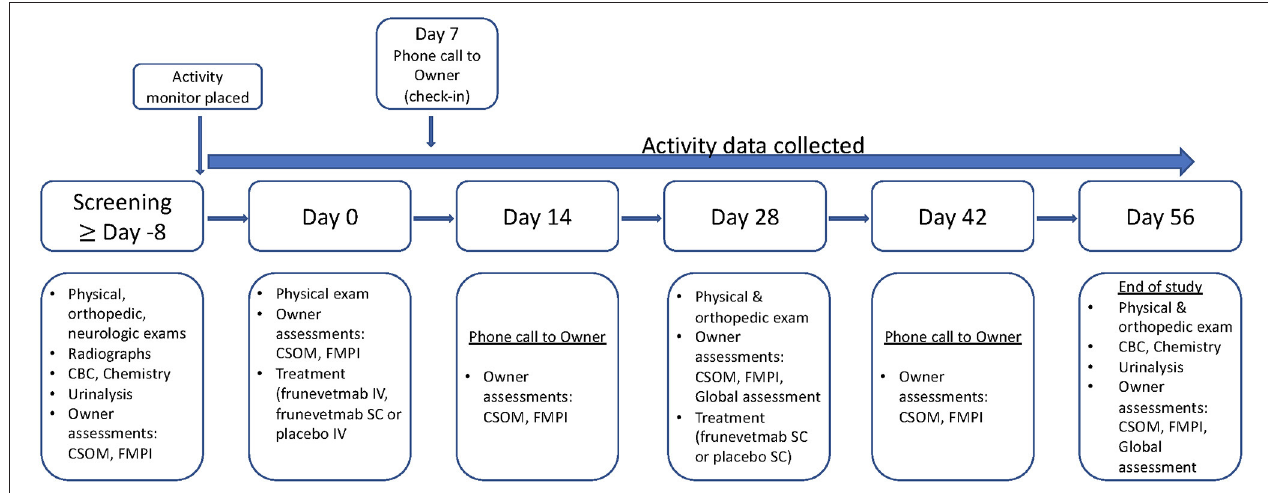
FIGURE 1 | Timeline of events for the pilot field study. CBC, complete blood count; CSOM, client-specific outcome measure; FMPI, feline musculoskeletal pain